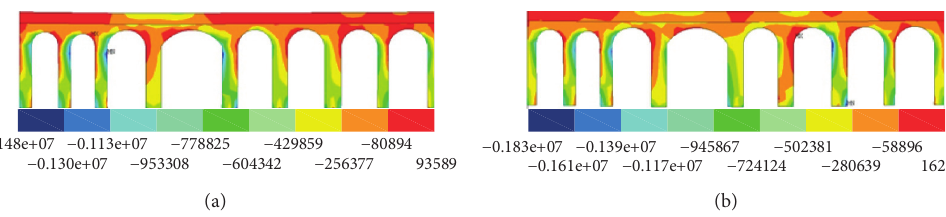
Figure 11: Third principal stress of aqueduct. (a) After the excavation of the left tunnel. (b) After the excavation of the right